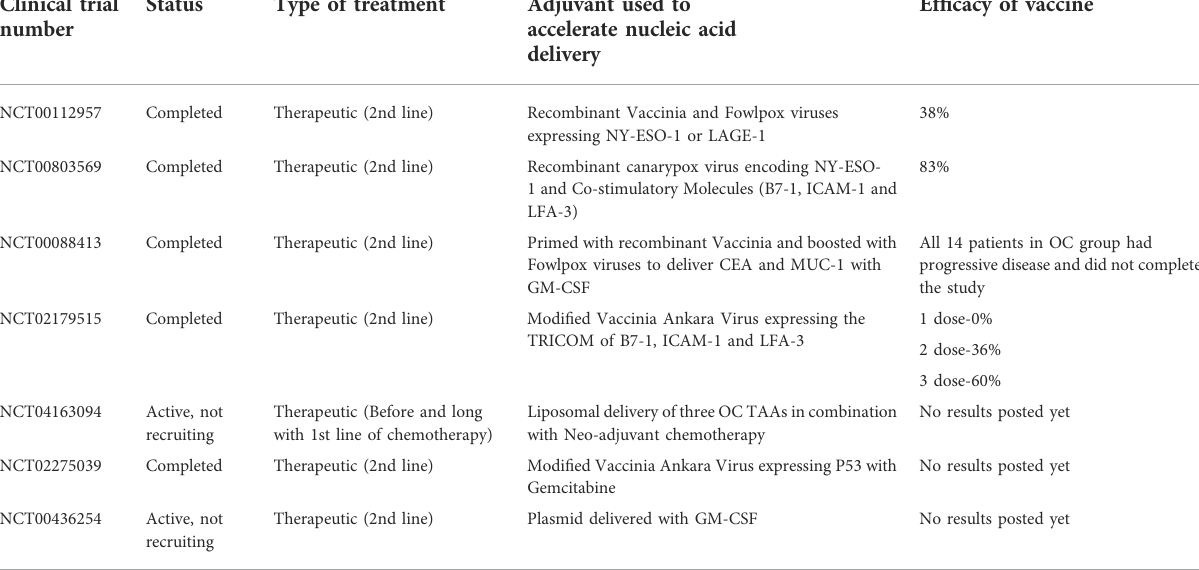
TABLE 4 Table of clinical trials showing adjuvants used to accelerate Nucleic acid delivery for various cancer vaccines in OC. Clinical trial